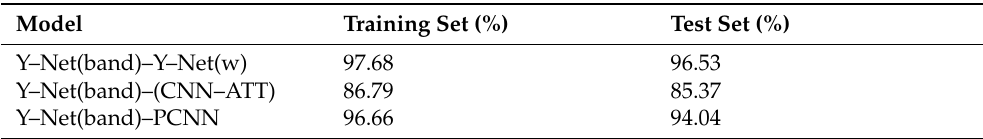
Figure 8. ( a ) Comparison plots of training accuracy and the number of iterations; ( b ) comparison plots of loss values and the number of iterations. Table 2. Classification performance of Y–Net(w) and other networks.